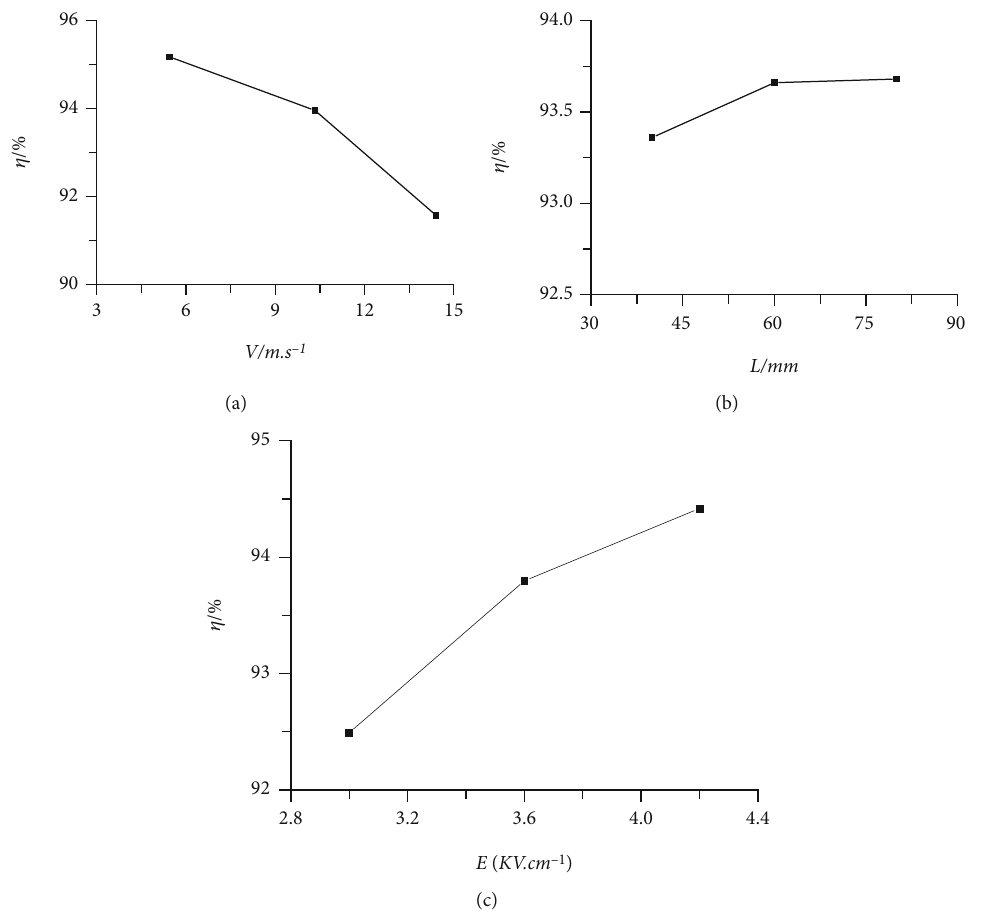
Figure 4: Analysis of in fl uencing factors in orthogonal